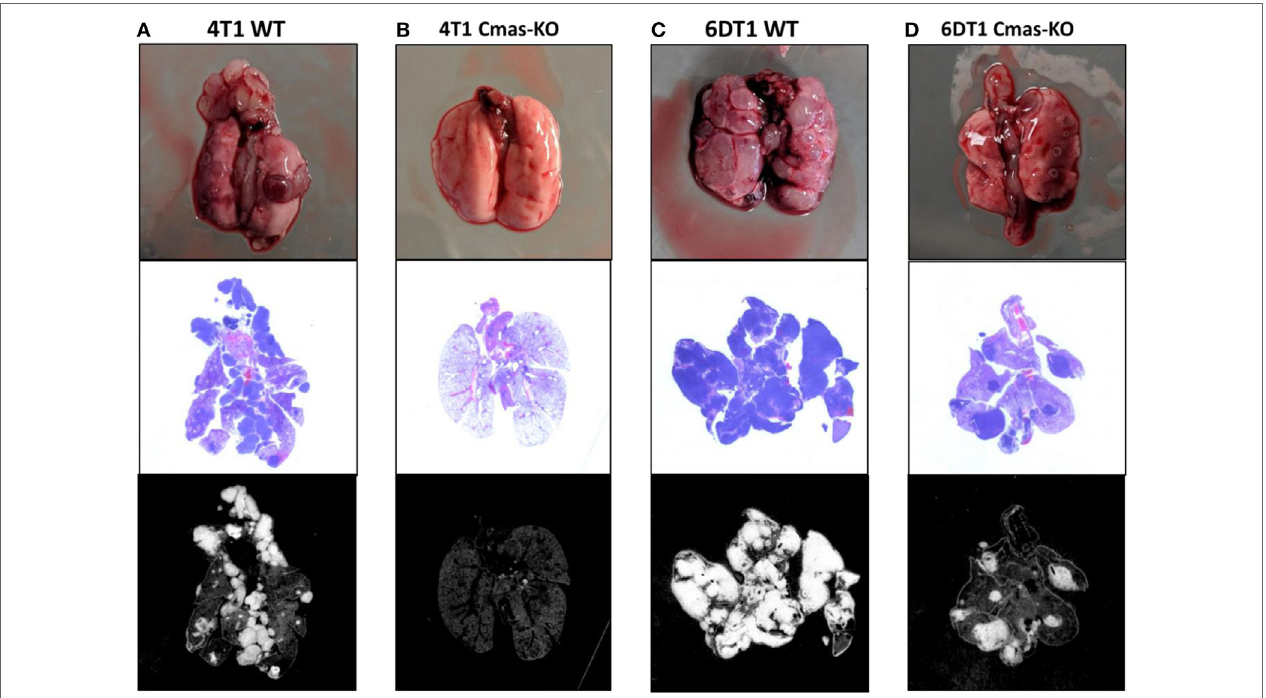
FigUre 7 | Representative images of lungs from mice injected with Cmas WT and KO cells. (a) Lungs from mice orthotopically injected with 4T1 wild-type cells showing high extent of metastasis. (B) Lungs from mice injected with 4T1 Cmas -KO cells showing almost no metastasis. (c) Lungs from mice injected with 6DT1 wild-type cells showing extremely high extent of metastasis. (D) Lungs from mice injected with 6DT1 Cmas -KO cells showing relatively low extent of metastasis. Top row: lungs photographed at necropsy. Middle row: histology images showing hematoxylin and eosin (H&E) staining. Metastatic tumor tissue is identified by nuclei-dense regions showing high hematoxylin (blue) staining. Bottom row: histology images processed in ImageJ to highlight the regions used for area quantification. Images are not perfectly matched in